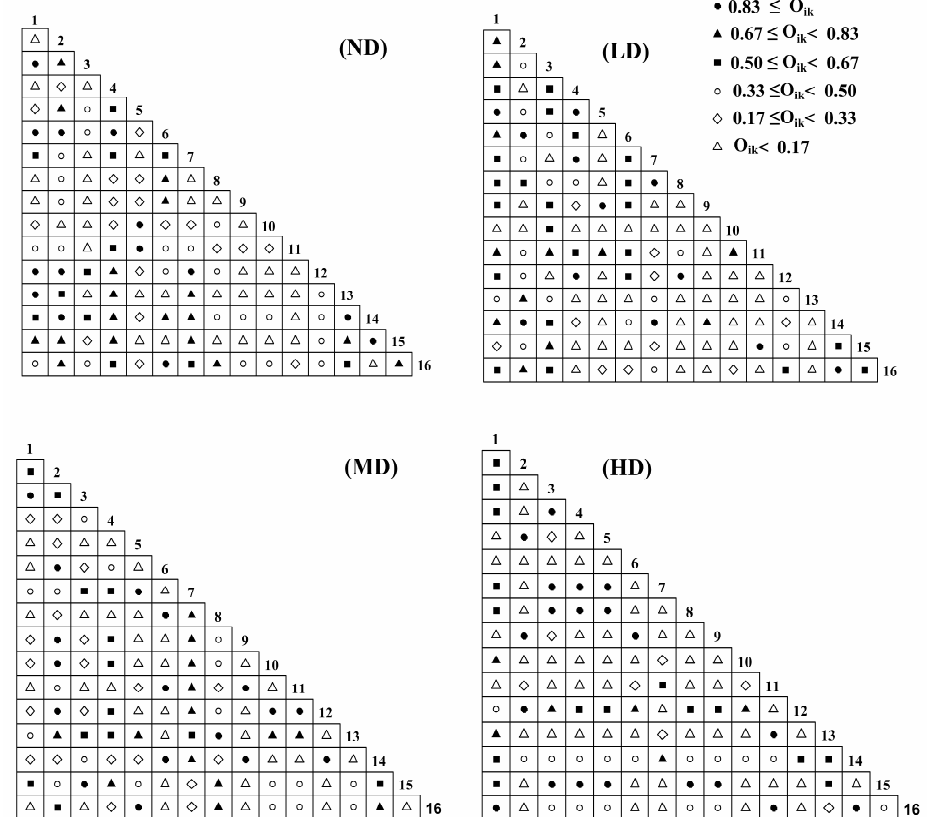
Figure 1. Niche overlap values of major species at different desertification stages in the Qinghai Lake Basin. Values 1–16 outside the table represent different plant species. ND stands for not desertification, LD for light desertification, MD for moderate desertification, HD for heavy desertification. See Table 1 for the meanings of species numbers.